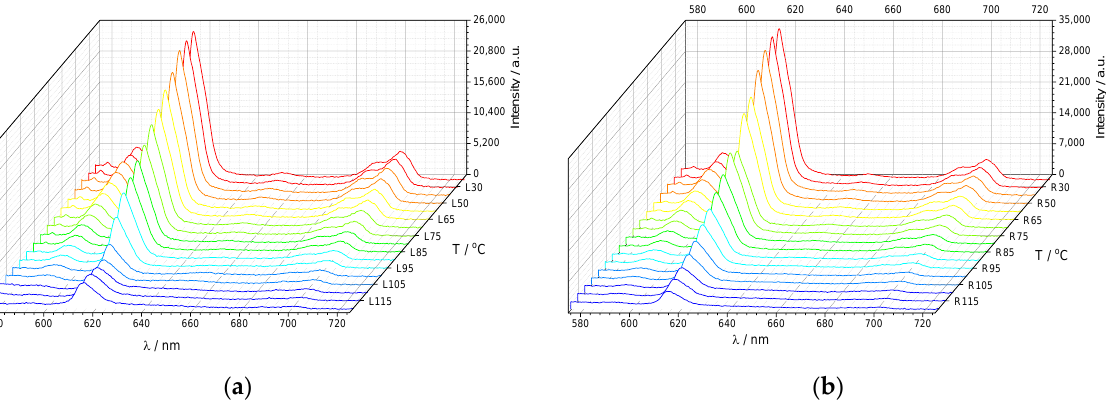
Figure 5. Spectra of the left- ( a ) and right-handed ( b ) circularly polarized luminescence recorded at different temperatures upon heating at a rate of 1 °C/min. Excitation: 365 nm LED.